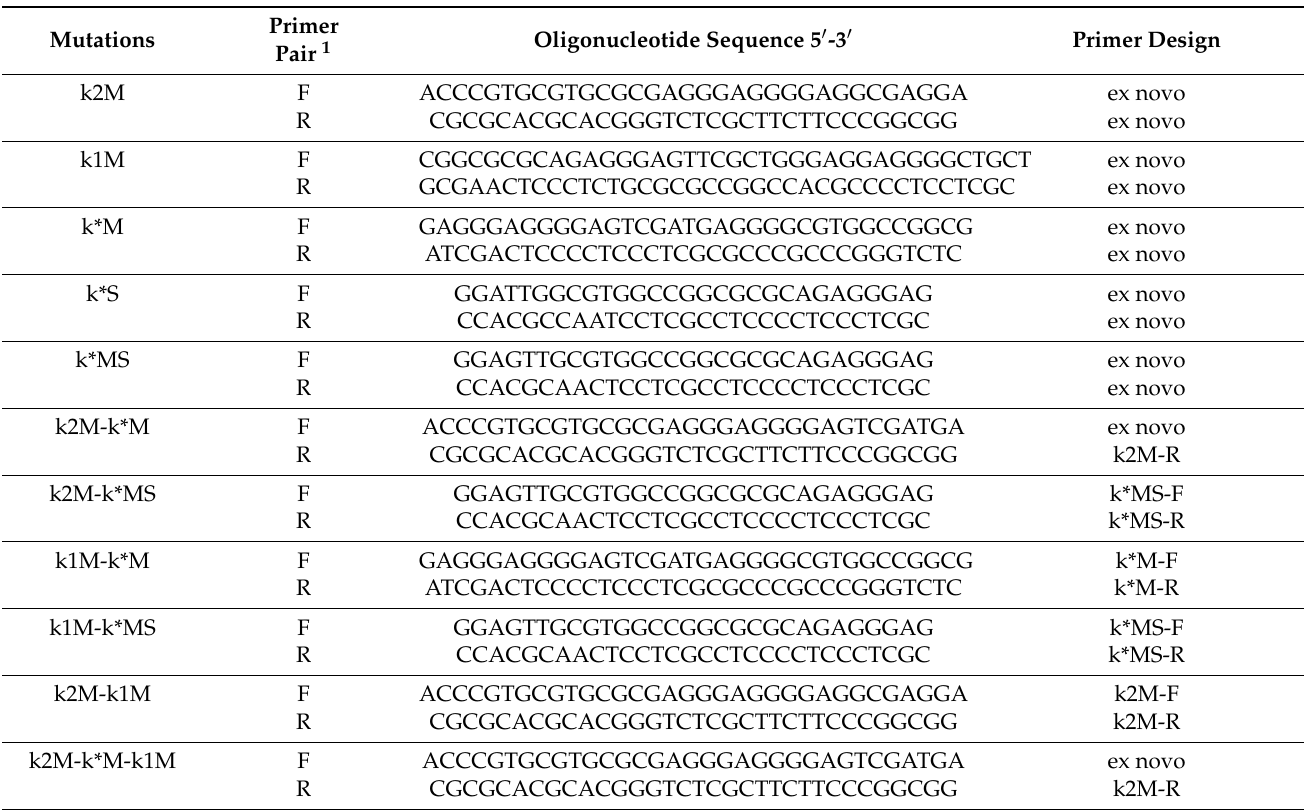
Table 3. Primer pairs used for site-directed